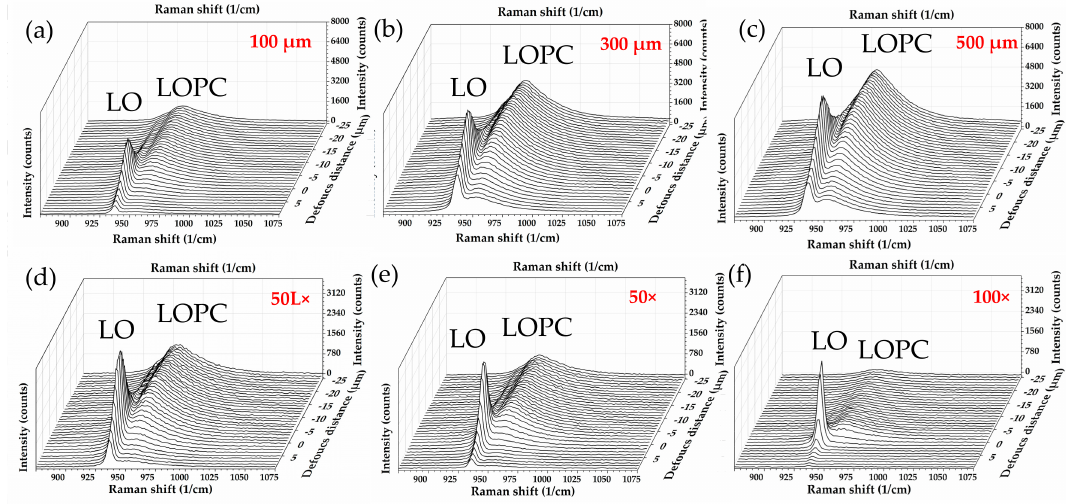
Figure 4. Depth profiling of sample Q1 with di ff erent pinhole sizes (a–c) and lenses with di ff erent N.A. (d–f): ( a ) was obtained by 50L × and 100 µ m pinhole; ( b ) was obtained by 50L × and 300 µ m pinhole; ( c ) was obtained by 50L × and 500 µ m pinhole; ( d ) was obtained by 50L × (long working distance objective lens) and 100 µ m pinhole; ( e ) was obtained by 50 × and 100 µ m pinhole; ( f ) was obtained by 100 × and 100 µ m pinhole. The step of depth profiling is 1 µ